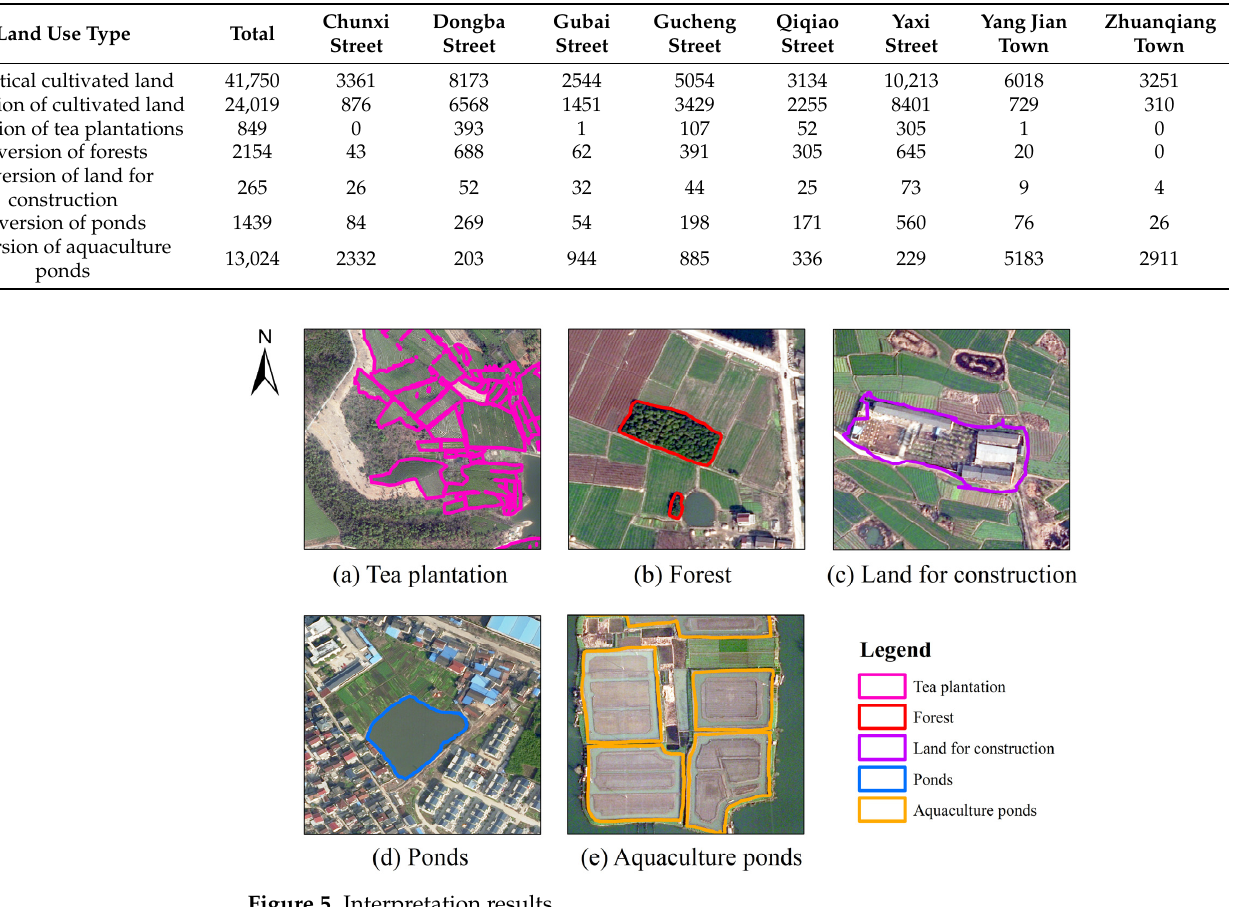
Table 5. Interpretation of cultivated land in Gaochun District. Unit: hectare.